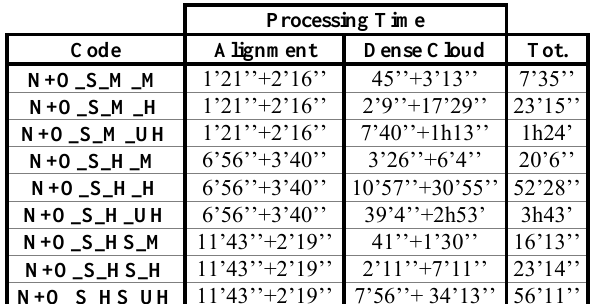
Table 3. Number of Points in case of sparse and dense point cloud for all